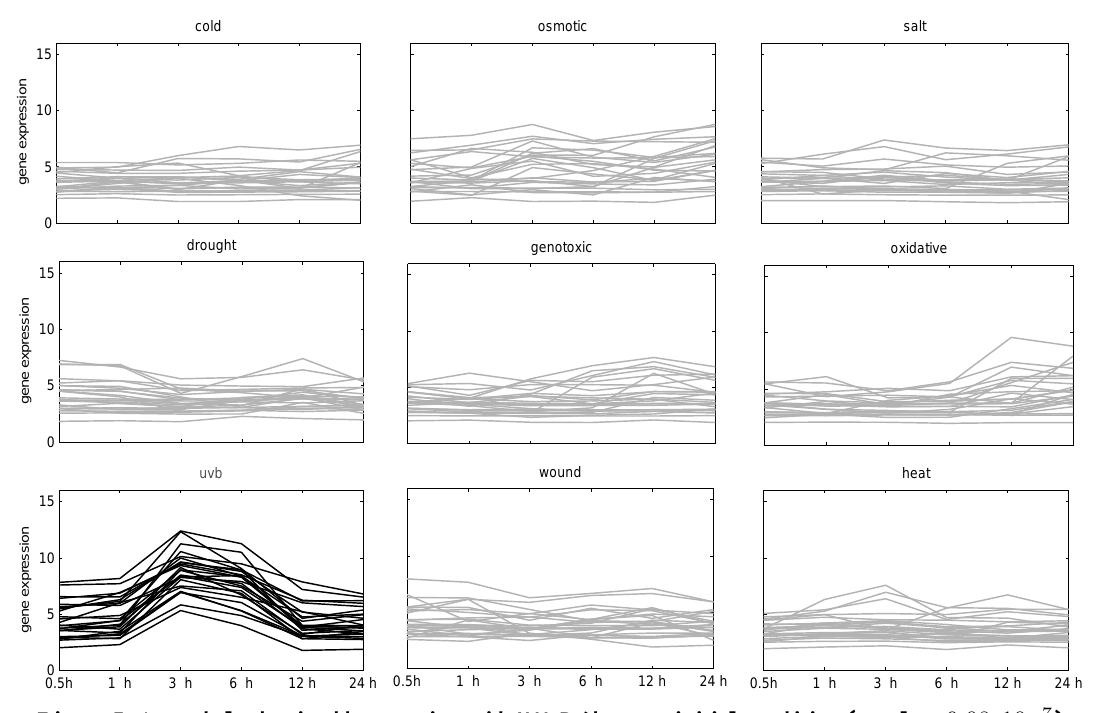
Figure 5: A module obtained by starting with UV-B/shoot as initial condition ( p -value: 9 . 08 · 10 − 7 ). Obviously, the genes participating in the initial cluster do not cluster under the other conditions. This is an example for a single response module, which is specific for the highlighted condition